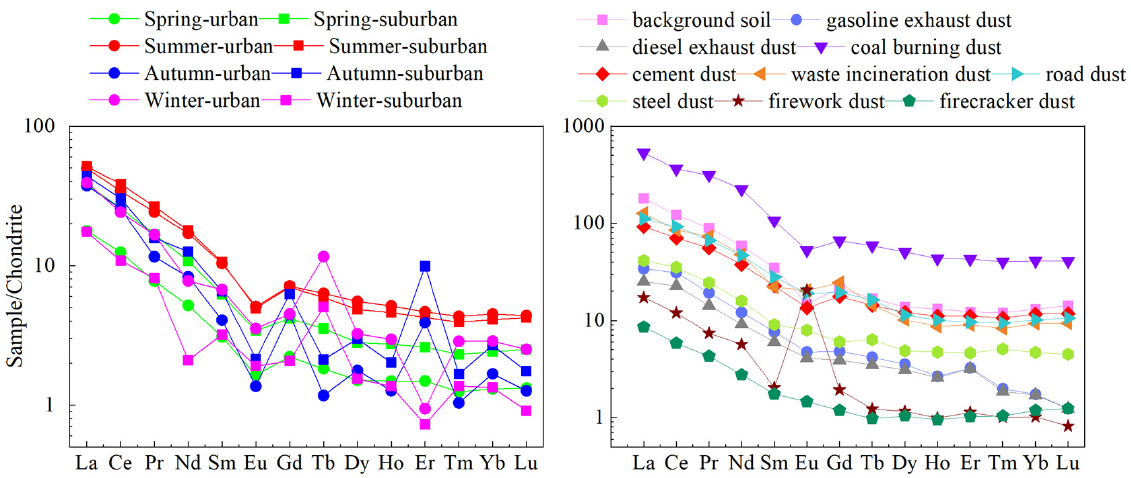
Figure 3. Chondrite-normalized REE distribution patterns in PM 2.5 ( left ) and potential sources ( right ) in Xiamen.